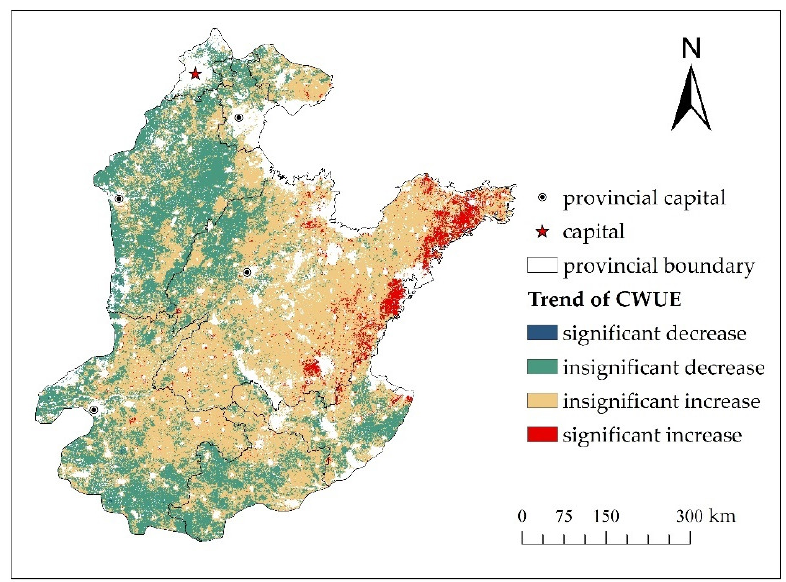
Table 8. Statistics of the cropland water use efficiency (CWUE) trend.